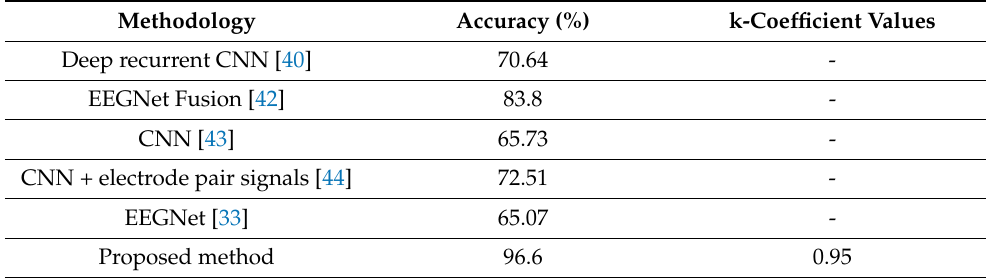
Table 5. Comparison with state-of-the-art